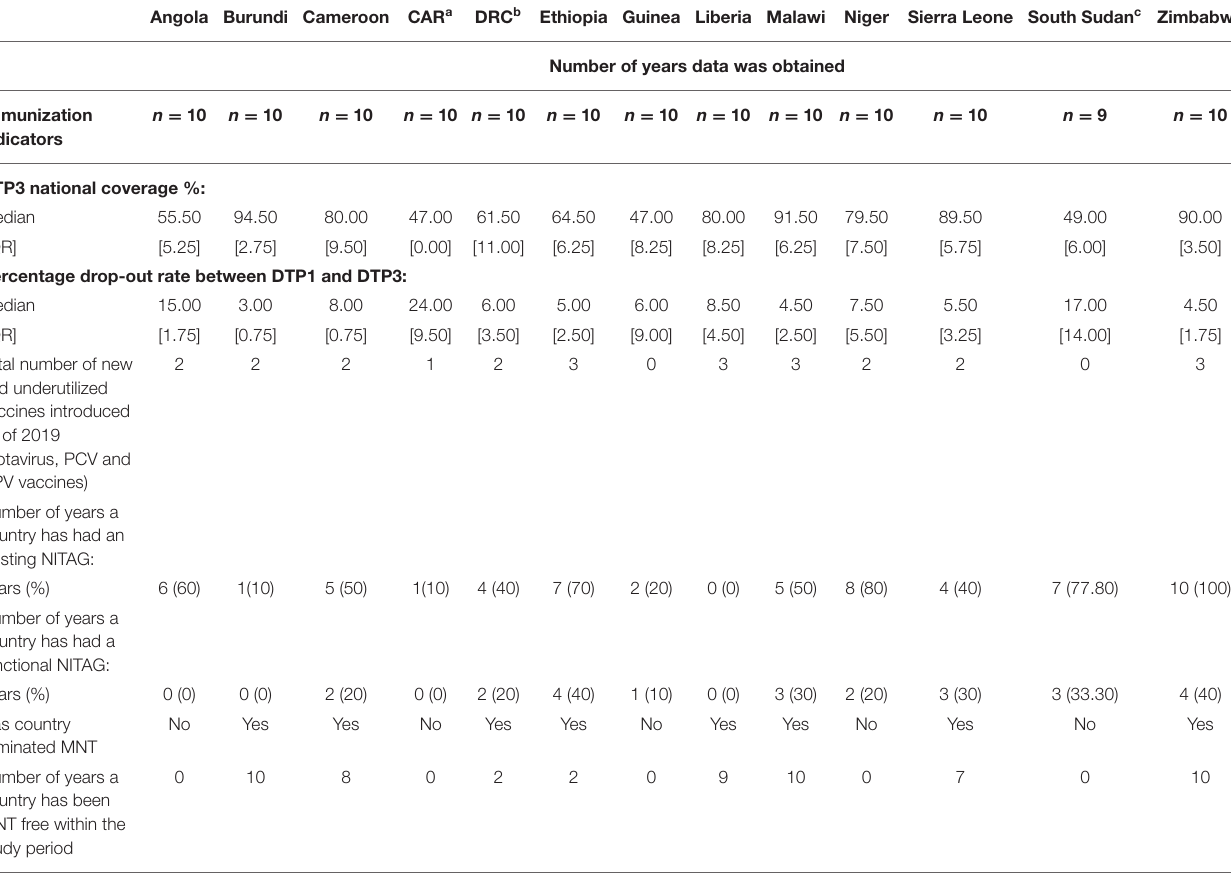
TABLE 2 | Descriptive summary of NIP related immunization indicators between 2010 and 2019 stratified by